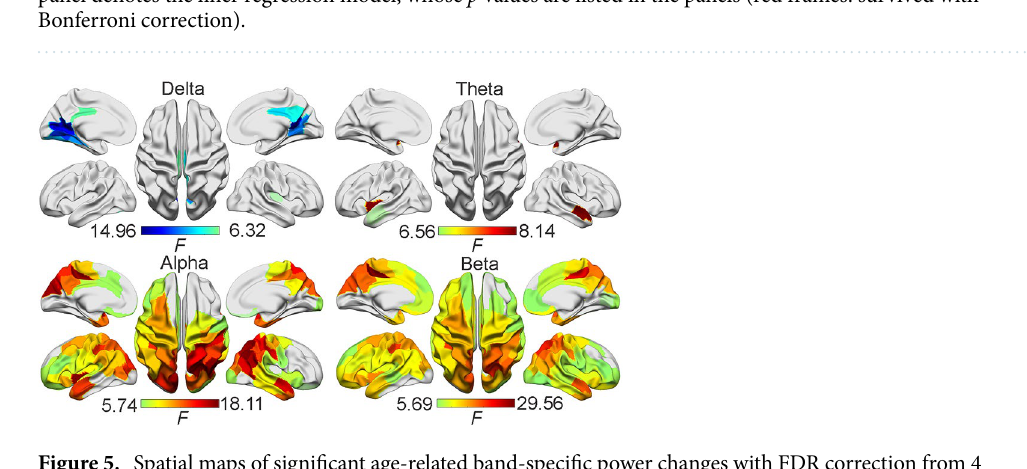
Figure 5. Spatial maps of significant age-related band-specific power changes with FDR correction from 4 frequency bands and 100 parcellations. Blue: decreases as age increases; Red: increases as age